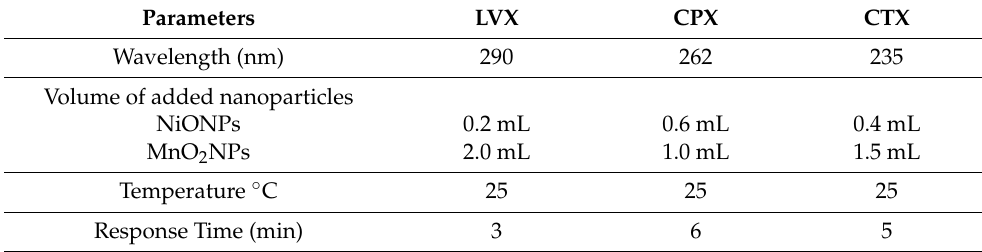
Table 1. Optimized conditions for the determination of LVX, CPX, and CTX using the proposed spectrophotometric method in the presence of NiONPs and MnO 2 NPs, respectively. Parameters LVX CPX CTX Wavelength (nm)